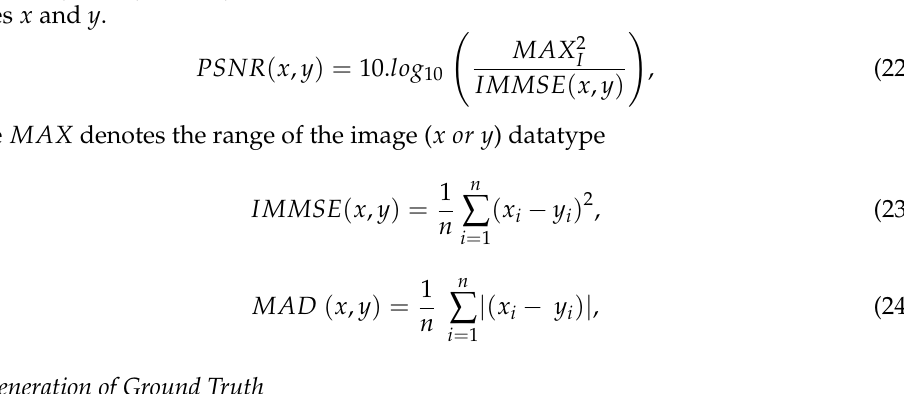
Figure 9. Evaluation results for SRD performances of proposed method for 122 specular reflected images (121 sub-aper- tures + 1 maximum) of nine sample objects separately using different SRD metrics. Similarly, Figure 10 shows the combined SRD rates for 121 sub-aperture + 1 maxi- mum images × 18 objects = 2196 images. Accuracy has a better overall median and 75th percentile values for all the objects combined (0.981 and 0.992, respectively) compared to the F1-score (0.643 and 0.770, respectively) and the G-mean (0.656 and 0.752, respectively).